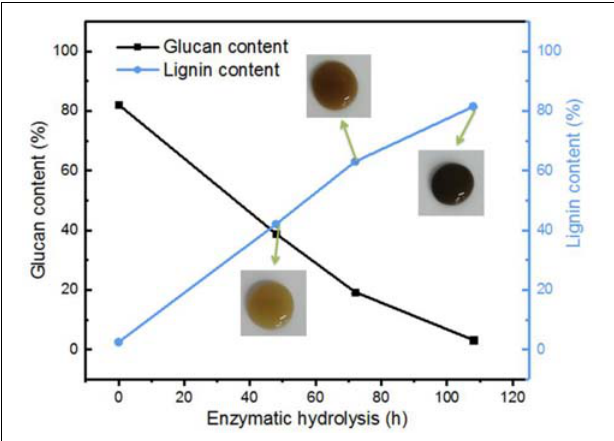
FIGURE 1 | Lignin and glucan content in the EHRs after different enzymatic hydrolysis